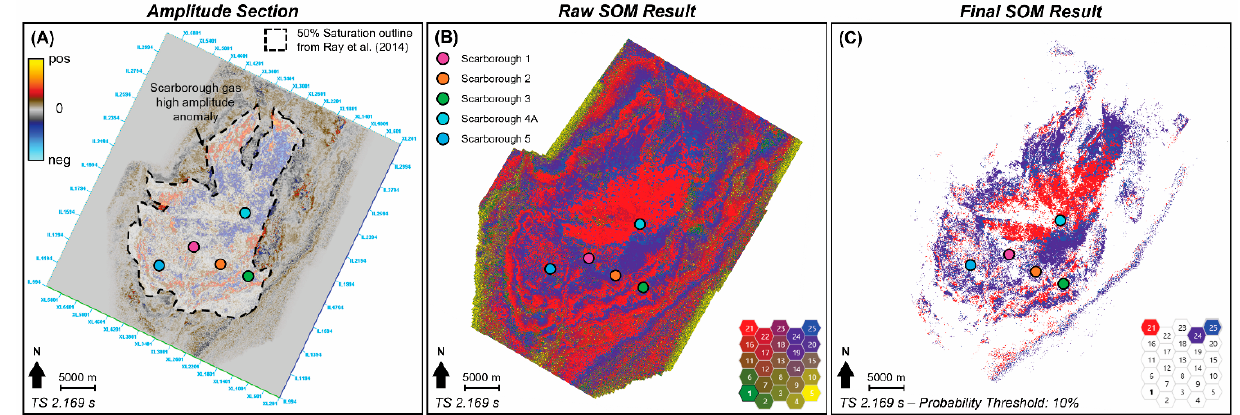
Figure 13. ( A ) Post-stack seismic amplitude time slice at 2.169 s illustrating the amplitude anomaly within the Scarborough gas field, whereas ( B ) shows the raw SOM results of that same time slice. ( C ) Shows the same SOM result with only the neurons of interest displayed with a probability threshold of 10% applied. In this view, the entire extent of the gas reservoir is highlighted. This boundary coincides well with Ray et al. [4]’s 50% saturation line. However, this method proved to be unsuccessful within this survey as it did not give us any qualitative information regarding gas saturation throughout the reservoir.